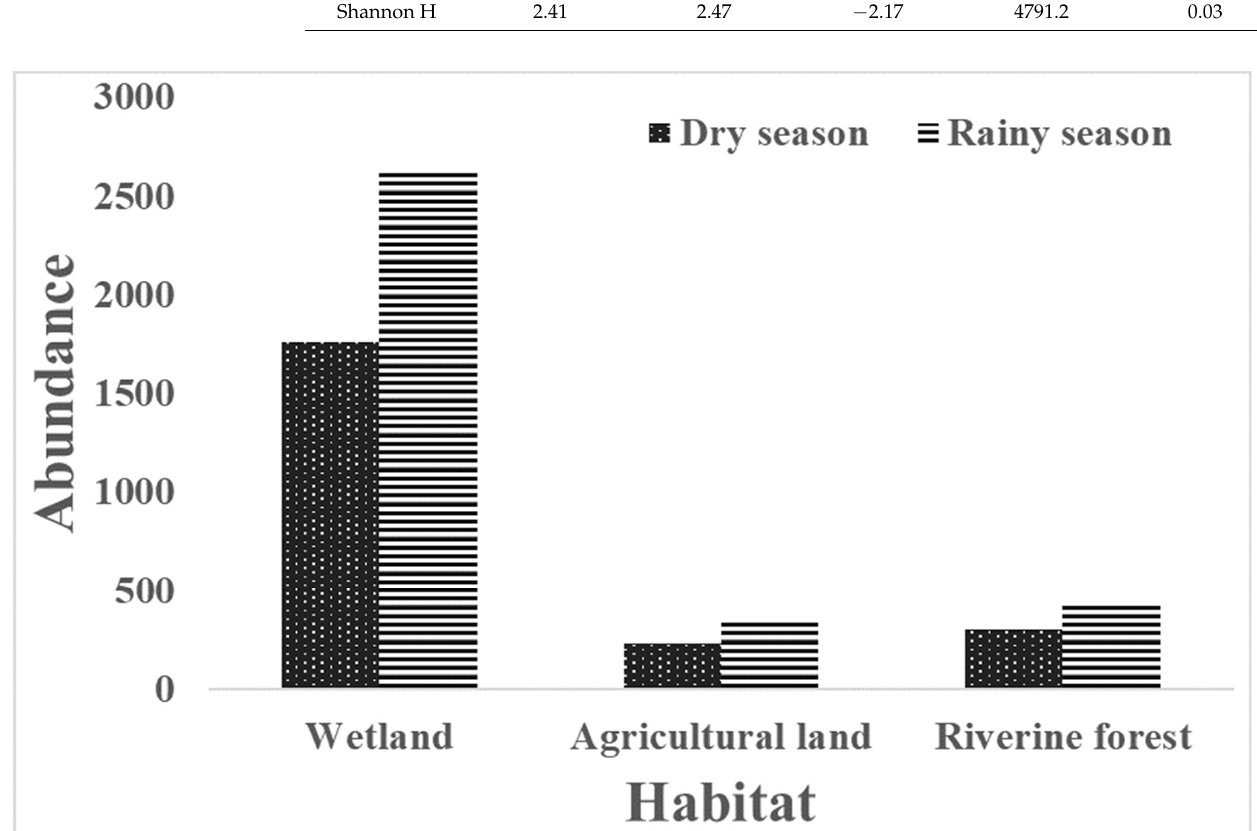
Figure 9. Seasonal variation of frog abundance among the three habitat